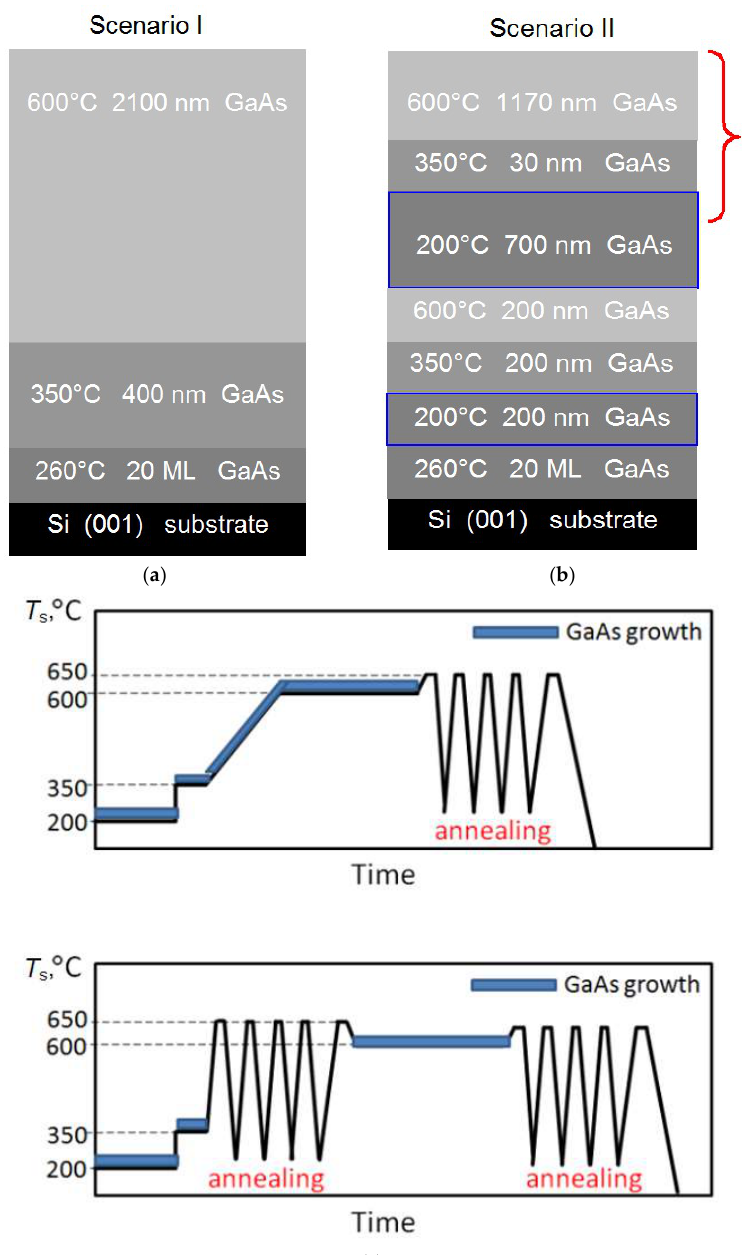
Figure 1. Profiles of GaAs/Si HSs grown according to Scenario I ( a ) and scenario II ( b ). The T S values and layer thickness values are shown in the panels. The LT-GaAs layers grown at T S = 200 °C are marked with blue lines. ( c ) The T S sequence during the growth of the HS section marked with a red curly bracket in panel ( b ). The blue thick lines correspond to the GaAs growth points. The top panel ( c ) corresponds to the HS growth with a gradual rise in T S , and the lower panel corresponds to the HS growth with the intermediate cyclic annealing.